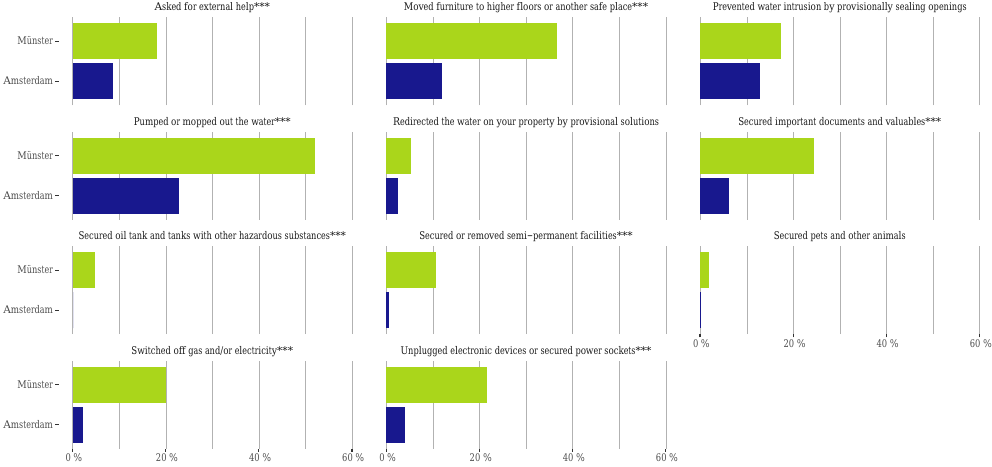
Figure 3. Percentage of respondents undertaking emergency measures. Only emergency measures that were asked in both cities are shown. A significant difference between proportions is denoted as follows: ∗ = p < 0 . 05, ∗∗ = p < 0 . 01, ∗∗∗ = p < 0 . 001 .